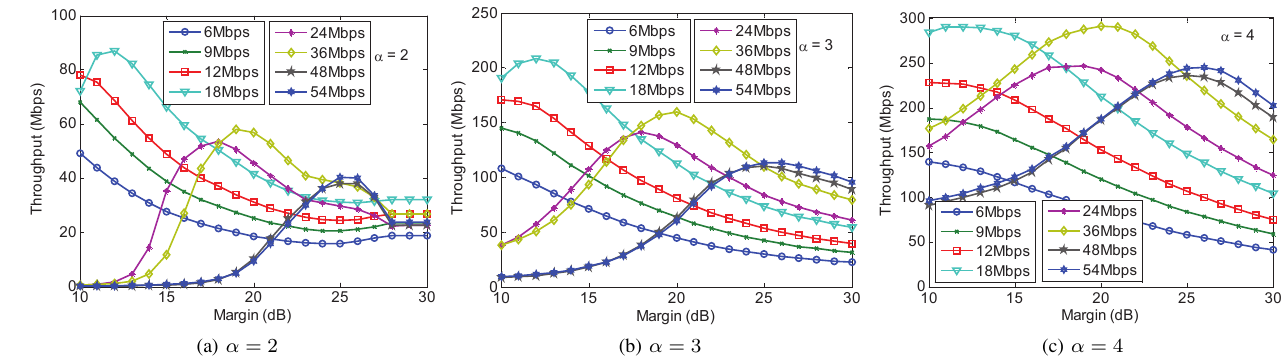
Throughput with the different carrier sensing thresholds for each fixed transmission rate. The joint optimizations of carrier sensing threshold and transmission rate are (12 dB, 18 Mbps), (12 dB, 18 Mbps) and (20 dB, 36 Mbps) for α = 2 , 3 , 4 . TRANSMISSION RATE , SINR THRESHOLD , AND NORMALIZED NETWORK THROUGHPUT k ( R ( k ) ) γ th ( k )